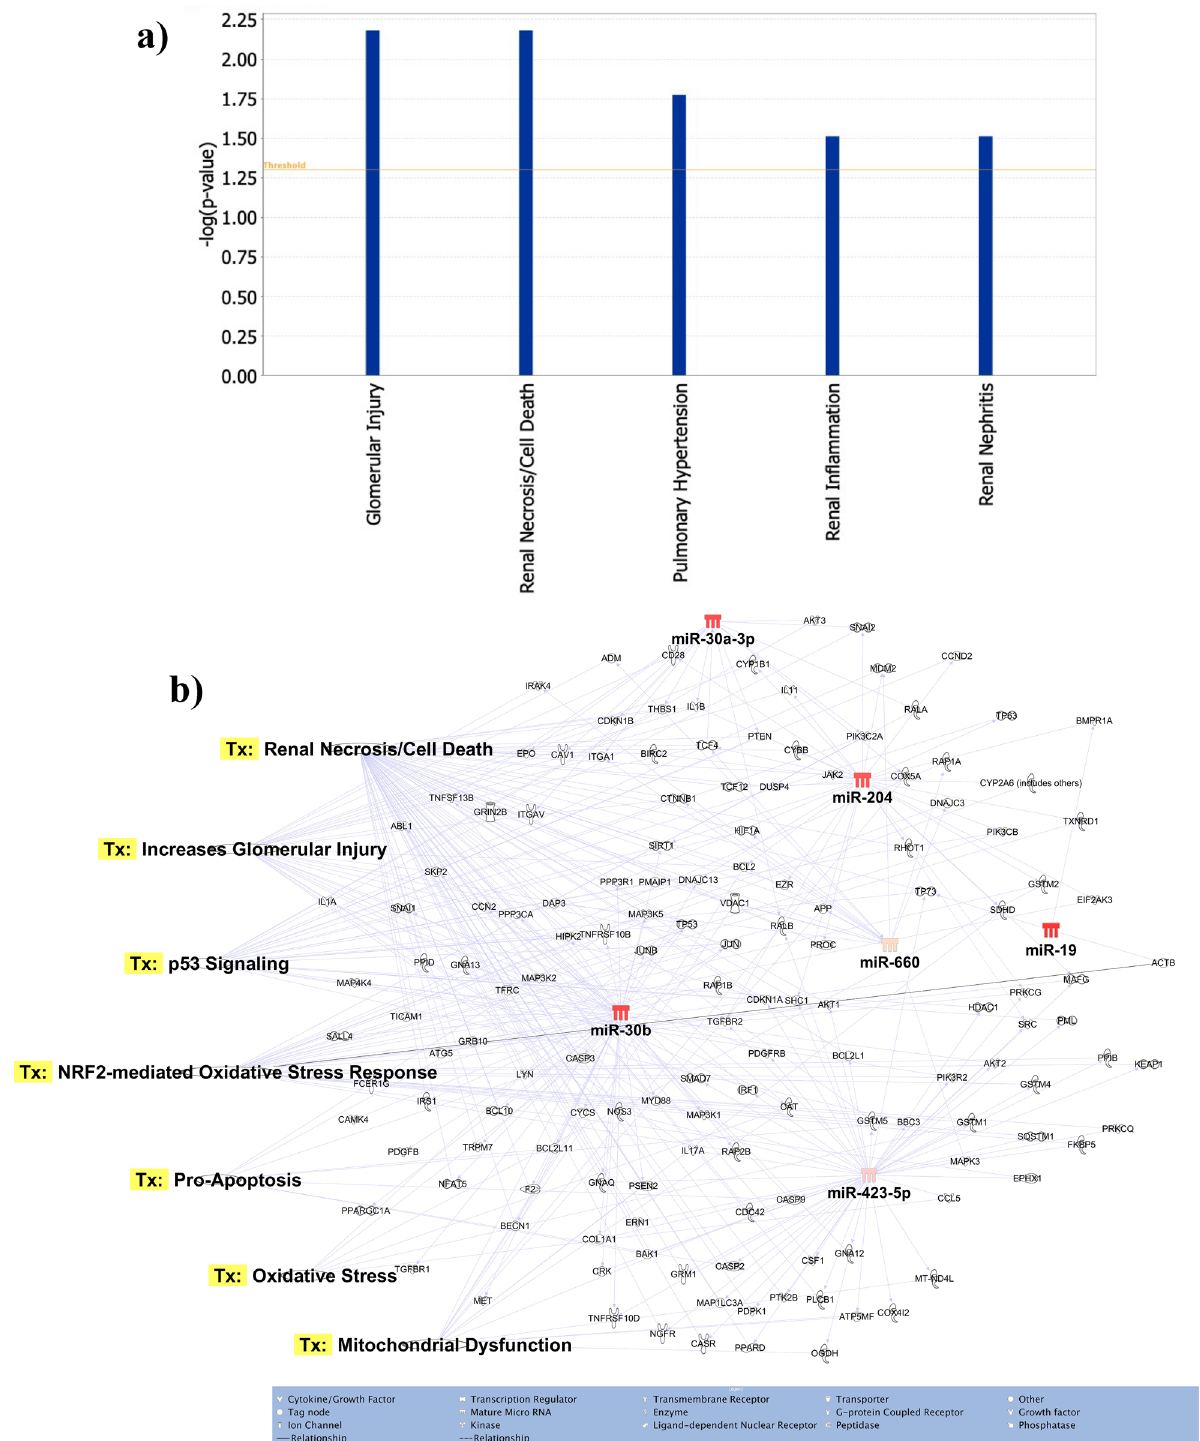
Figure 5. Functions and nephrotoxic pathways associated with target mRNAs of seven differentially expressed microRNAs in toxic-AKI. We analyzed the expression of the seven microRNAs using co-analysis in Ingenuity Pathway Analysis (IPA), (QIAGEN, Inc., https:// targetexplorer.ingenuity.com/) and a) shows the main disease and functions of the differentially expressed microRNAs. We used IPA to identify target mRNA and microRNA- mRNA interactions. Target mRNAs were overlaid on ‘Toxic’ functions derived from select microRNAs using ‘Pathway design’ option in IPA. The top seven toxic function pathway (Tx) networks identified for microRNA- mRNA interactions are presented